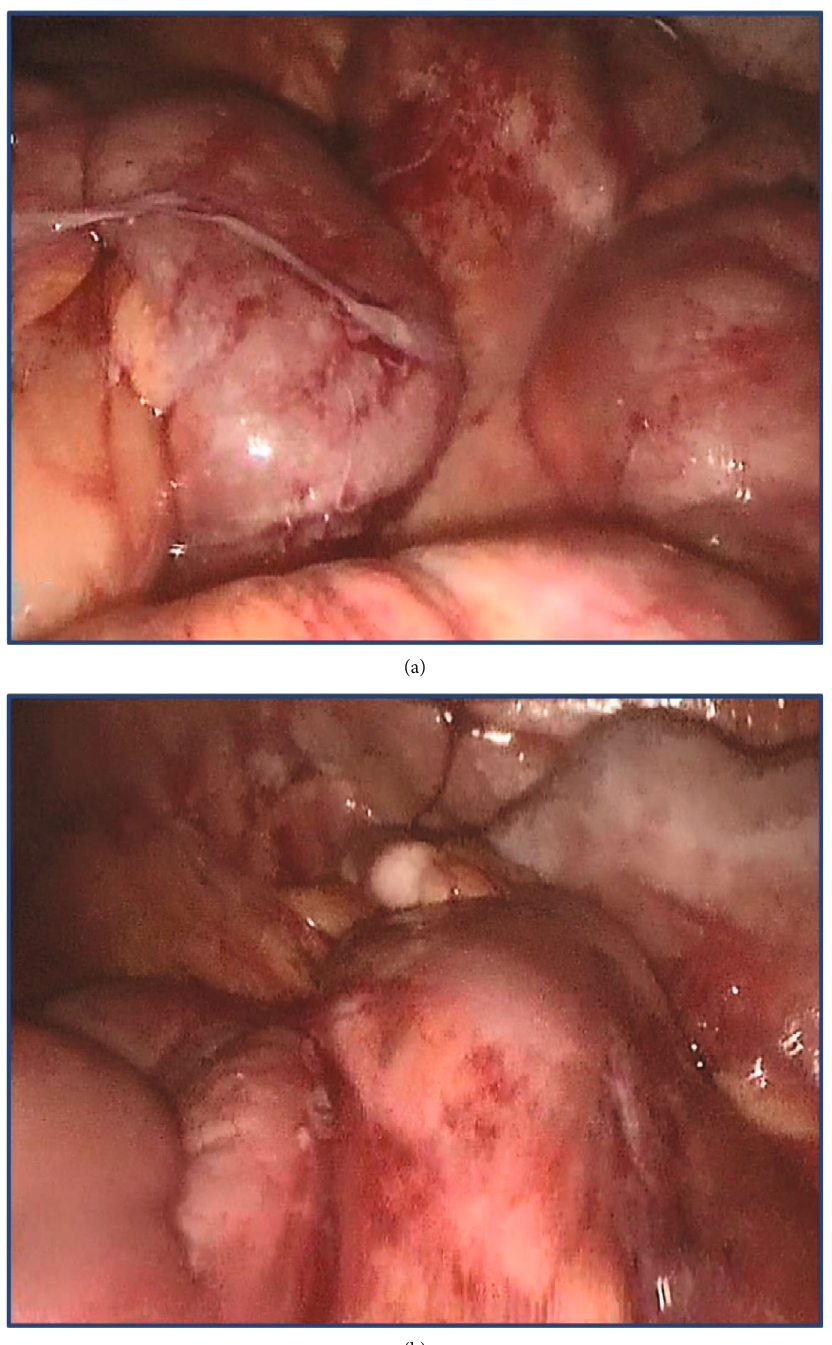
Figure 5: (a) A control diagnostic laparoscopy 6 weeks after cesarean delivery shows a full regression of ectopic deciduosis that covered small bowel loops. (b) A control diagnostic laparoscopy 6 weeks after cesarean delivery shows an entire regression of ectopic deciduosis that used to cover the terminal ileum and cecum